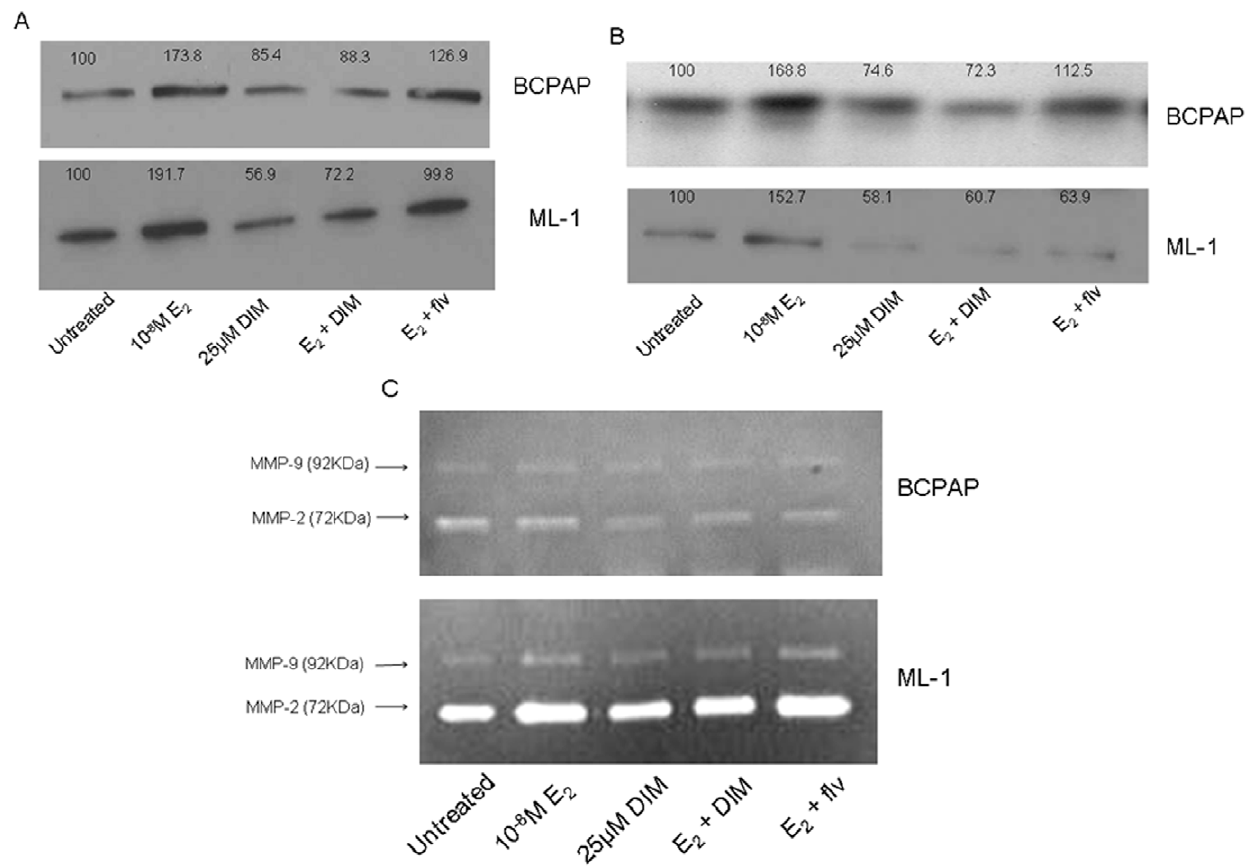
Figure 5. DIM reduces estrogen mediated enhancement of MMP-2/9 protein secretion and activity in thyroid cells. Conditioned medium from thyroid cells treated with 10 2 8 M E 2 6 10 2 6 M fulvestrant 6 25 m M DIM for 24 hours were collected and total protein concentration was determined. One microgram ( m g) of protein for each treatment was resolved by SDS-PAGE followed by Western blot analysis for MMP-2 (dilution 1:1000) (A), MMP-9 (dilution 1:1000) (B) and zymography (C). In zymography, areas of MMP enzymatic activity appeared as clear bands over the dark blue background. Shown are densitometric values with untreated samples set as 100% and average of three independent experiments.